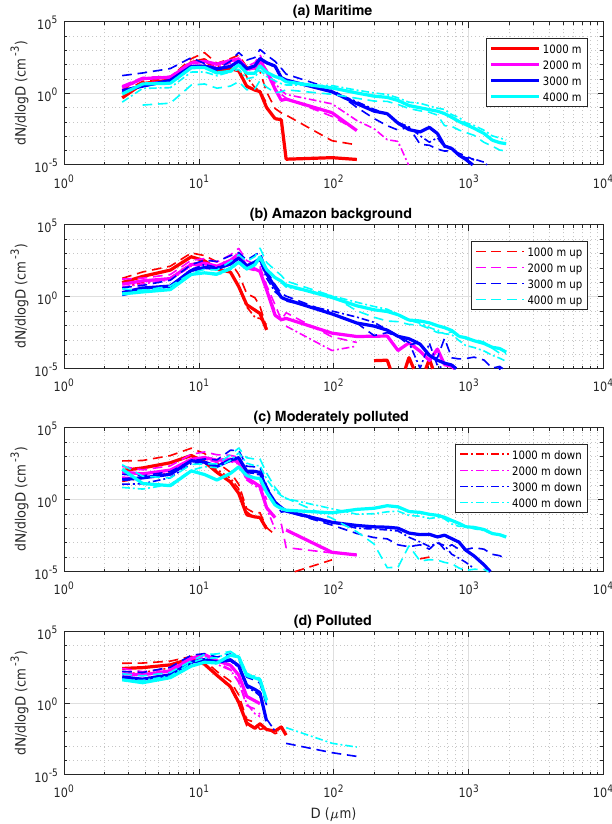
Figure 2. Droplet size distributions as functions of altitude above cloud base, aerosol particle number concentration, and vertical wind speed ( W ). Four 1000m thick layers are considered in the vertical, and the legends in the graphs show the respective up- per limit of each one. Solid lines represent averaged DSDs for − 1ms − 1 ≤ W ≤ 1ms − 1 , i.e., for relatively neutral vertical move- ments. Dashed lines represent averaged DSDs for the updraft re- gions where W >1ms − 1 , and dotted–dashed lines represent the downdrafts ( W < − 1ms − 1 )